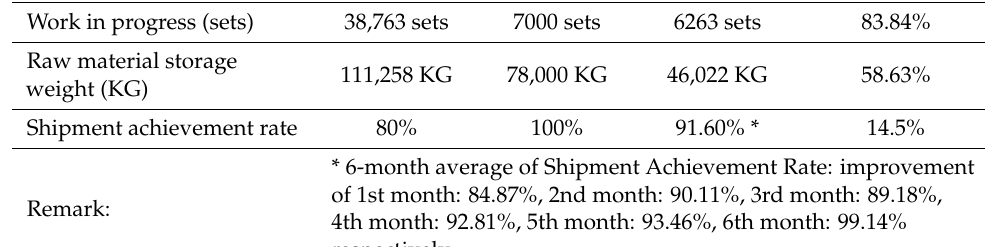
Table 15. Efficiency improvement statistics: before and after the improvement plan.